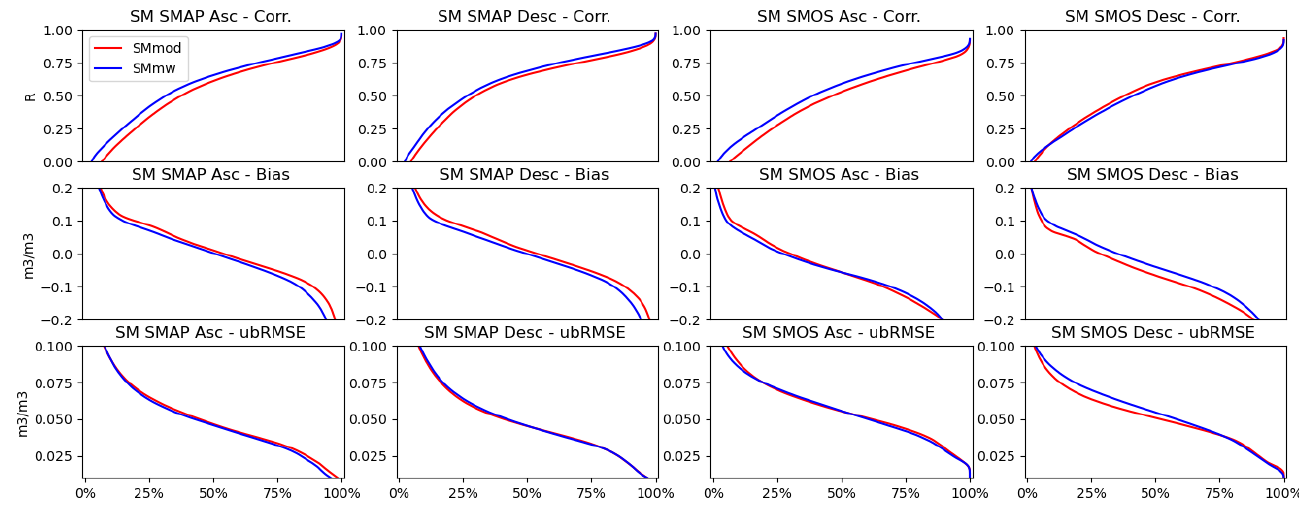
Figure 4. SMAP Desc SM mw and SM mod compared to ERA5. Results are shown for correlation (corr.), bias, and ubRMSE.